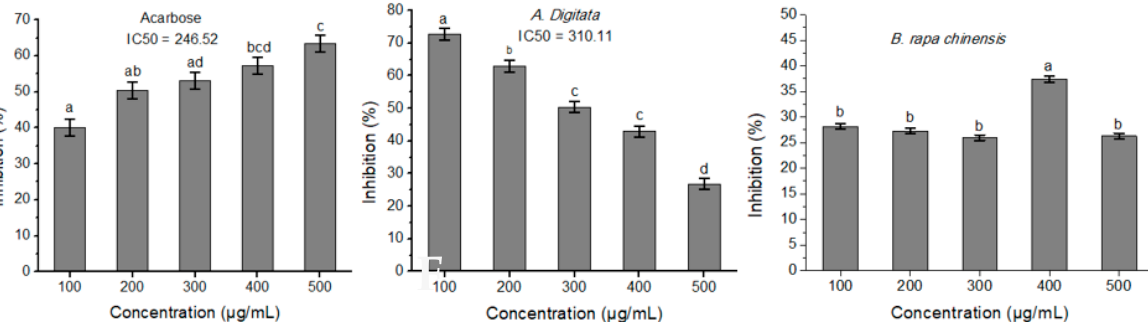
Figure 3. Scanning electron micrographs of Entodinium cells in the in vitro cultures after 24 h of incubation. ( A ) control, no plant inclusion, ( B ) Brassica rapa subsp. chinensis , ( C ) Kalimeris indica , ( D ) Calotropis gigantea , ( E ) Adansonia digitata , ( F ) Portulaca oleracea , ( G ) Flemingia macrophylla (roots), and ( H ) Flemingia macrophylla (leaves). The cells surface changes were observed at the highest tested dose (1.1 mg/mL) for each plant. No morphological changes to the cell surfaces were observed at the two lower doses or the negative control (not shown).